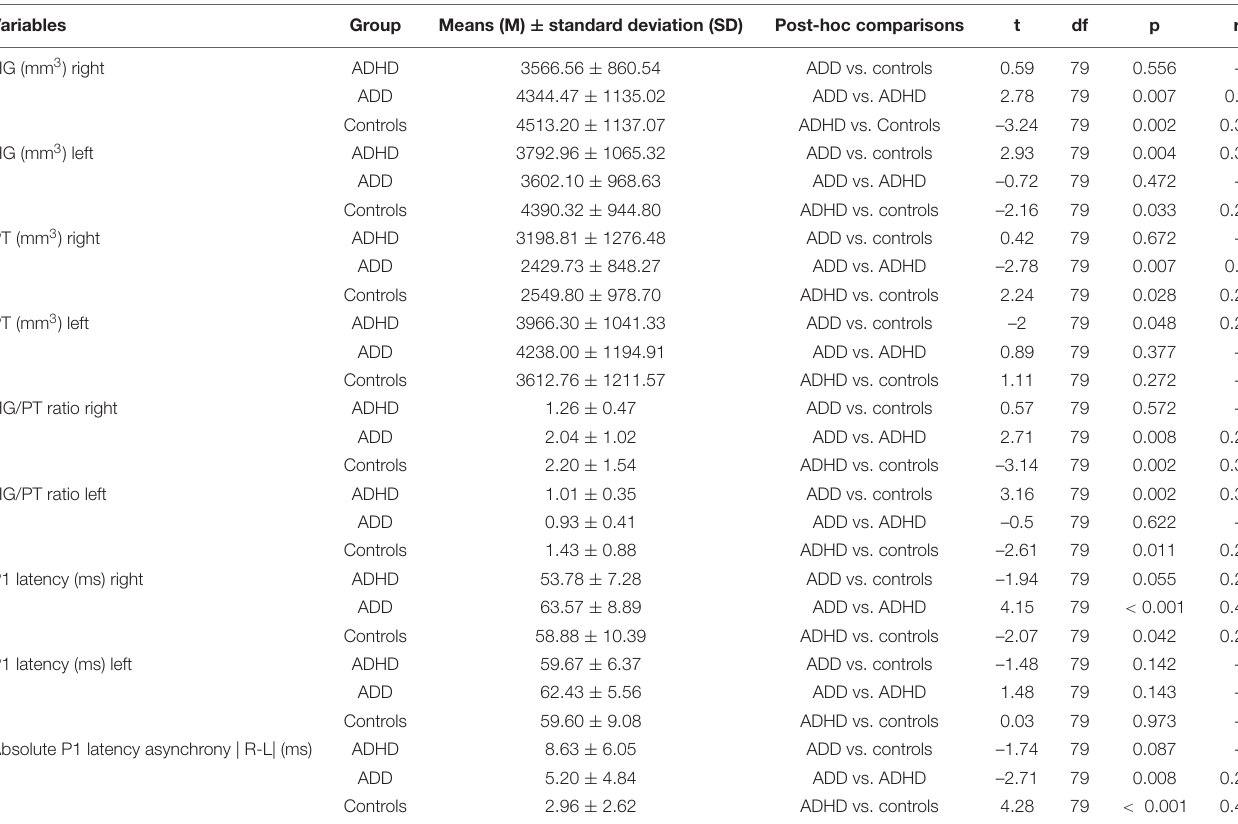
TABLE 4 | Games-Howell post hoc analysis on MRT and MEG variables.